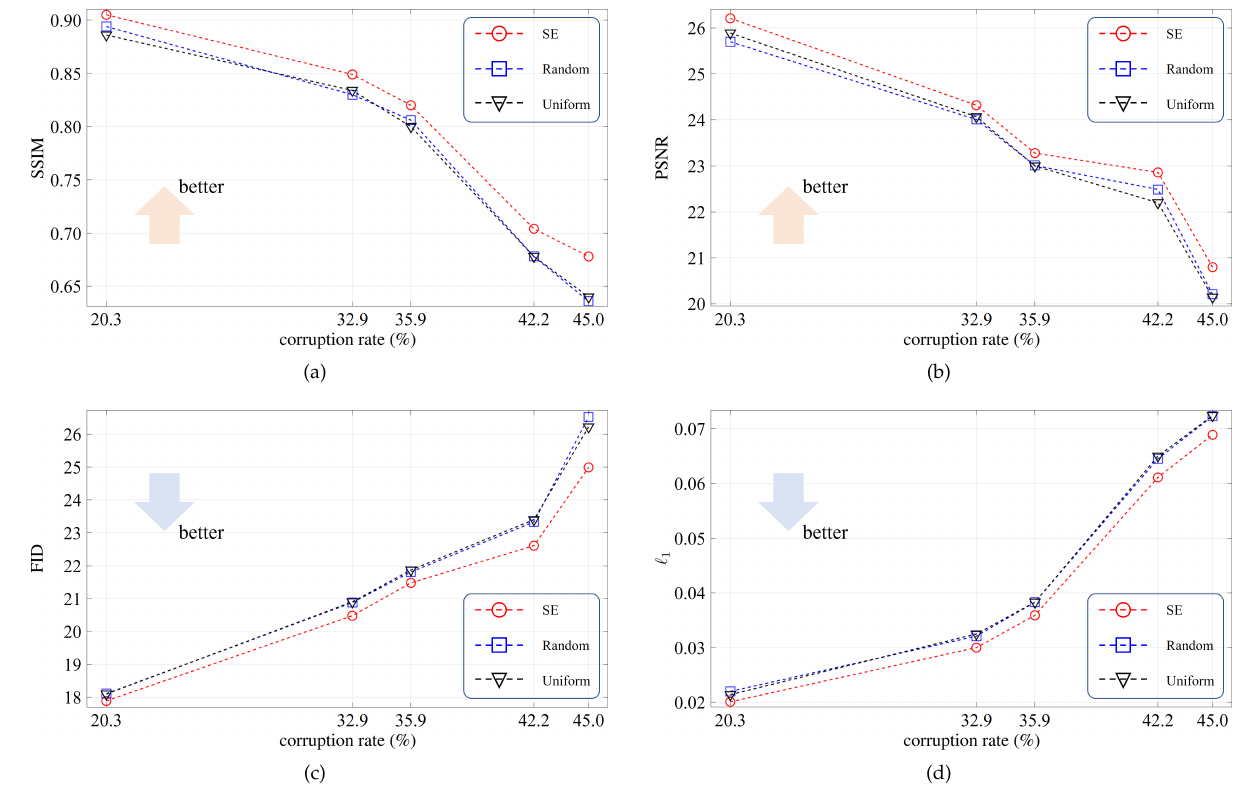
Figure 6. Quantitative results for the ablation study on the SE-based fusing module. red( a ) The SSIM scores. ( b ) The PSNR scores. ( c ) The FID scores. ( d ) The (cid:96) 1 scores.